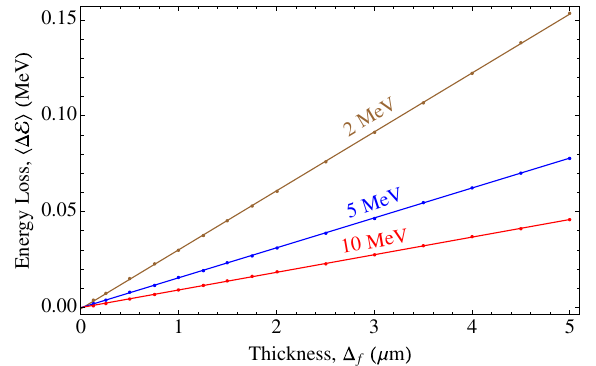
FIG. 2. Dots give smoothed (large angle events rejected) proton ¼ kinetic energy loss computed with SRIM, averaged over N p 3000 protons with initial kinetic energy E as indicated after b penetration of a solid aluminum foil of thickness Δ . Smoothing f eliminates less than 0.2% of the simulated protons in the worst ¼ 2 MeV and Δ ¼ 5 μ m. Solid lines correspond to case with E b f a linear fit of the data for initial kinetic energies E . Brown, blue, b ¼ 2 , 5, and and red colors represent initial kinetic energies E b 10